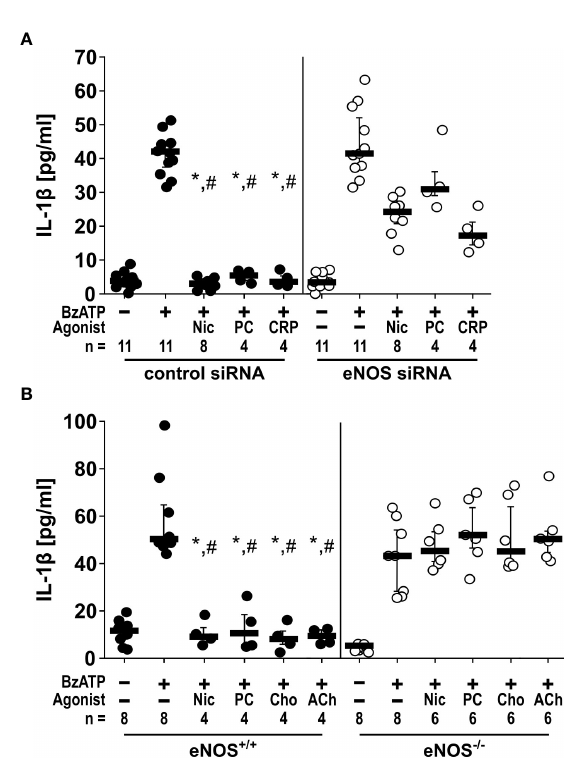
FIGURE 3 The inhibitory potential of cholinergic agonists on BzATP-induced IL-1 b release by monocytic cells depends on endothelial nitric oxide synthase (eNOS, NOS3 ) activity. (A) U937 cells were transfected with siRNA targeting eNOS or with control siRNA. Forty-eight hours after transfection, cells were primed with lipopolysaccharide (LPS; 1 µg/ ml) for 5 h and BzATP ((2 ’ /3 ’ -O-(4-benzoylbenzoyl)adenosine-5 ’ - triphosphate, tri(triethylammonium) salt; 100 µM) was given for additional 30 min in the presence or absence of nicotinic agonists nicotine (Nic; 100 µM), phosphocholine (PC; 100 µM) or C-reactive protein (CRP; 5 µg/ml). While in cells transfected with control siRNA, the BzATP-induced release of IL-1 b was inhibited by nicotinic agonists, the inhibitory activity of all agonists was blunted in eNOS siRNA-transfected cells. Data were analyzed by Kruskal-Wallis test followed by Mann-Whitney rank sum test. (B) Freshly isolated mouse peripheral blood mononuclear cells (PBMCs) isolated from wild-type (eNOS +/+ ) mice and mice de fi cient in eNOS (eNOS -/- ) were left untreated or stimulated with BzATP for 30 min, in the presence or absence of nicotinic agonists Nic, PC, choline (Cho; 100 µM) or acetylcholine (ACh; 10 µM). BzATP induced the release of IL-1 b in PBMCs obtained from all mouse strains. Nicotinic agonists signi fi cantly inhibited the IL-1 b release by PBMCs from eNOS +/+ mice. In contrast, the IL-1 b release by PBMCs from eNOS -/- mice was not affected by nicotinic agonists. Friedman test followed by the Wilcoxon signed-rank test. Data are presented as individual data points, bars represent median, whiskers percentiles 25 and 75. ∗ p ≤ 0.05 signi fi cantly different from samples, in which BzATP was given alone #p ≤ 0.05 signi fi cantly different from corresponding samples control siRNA vs. eNOS siRNA and eNOS +/+ vs. eNOS -/-